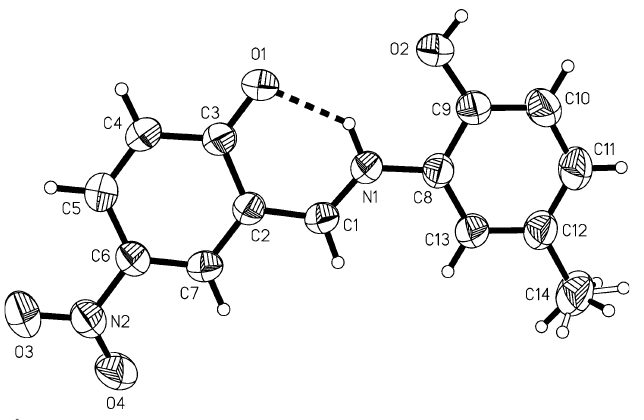
Figure 1 The molecular structure of the title compound, drawn with 50% probability displacement ellipsoids.